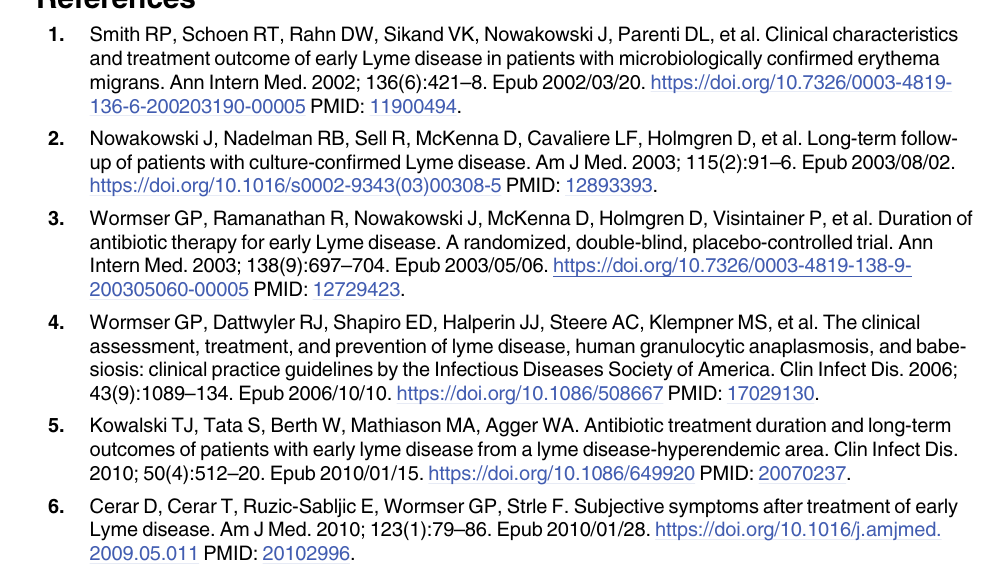
S2 Table. Questionnaires